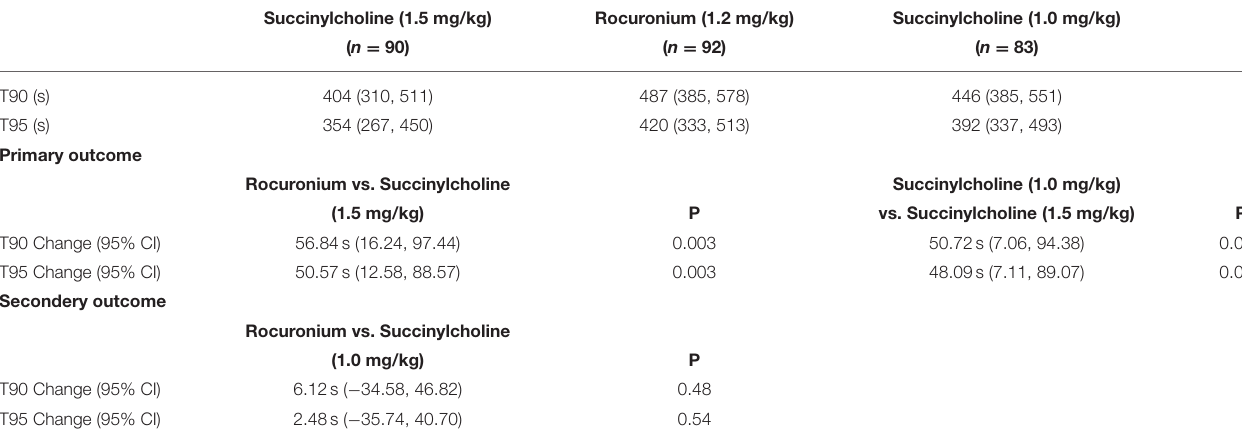
TABLE 2 | Non-hypoxic apnea duration.